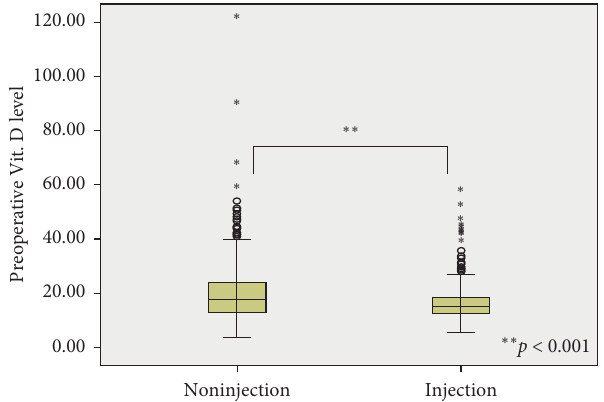
Figure 1: Comparison of preoperative 25-hydroxyvitamin D (25-OHD) levels between vitamin D3 injection (VDI) and vi- tamin D3 noninjection (VDN) groups.